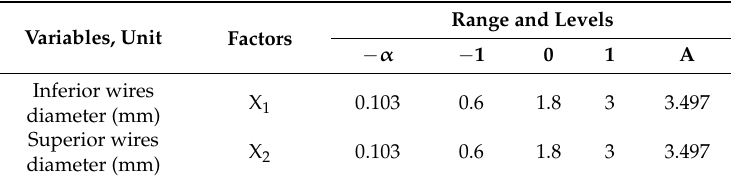
Table 3. The ranges of effective